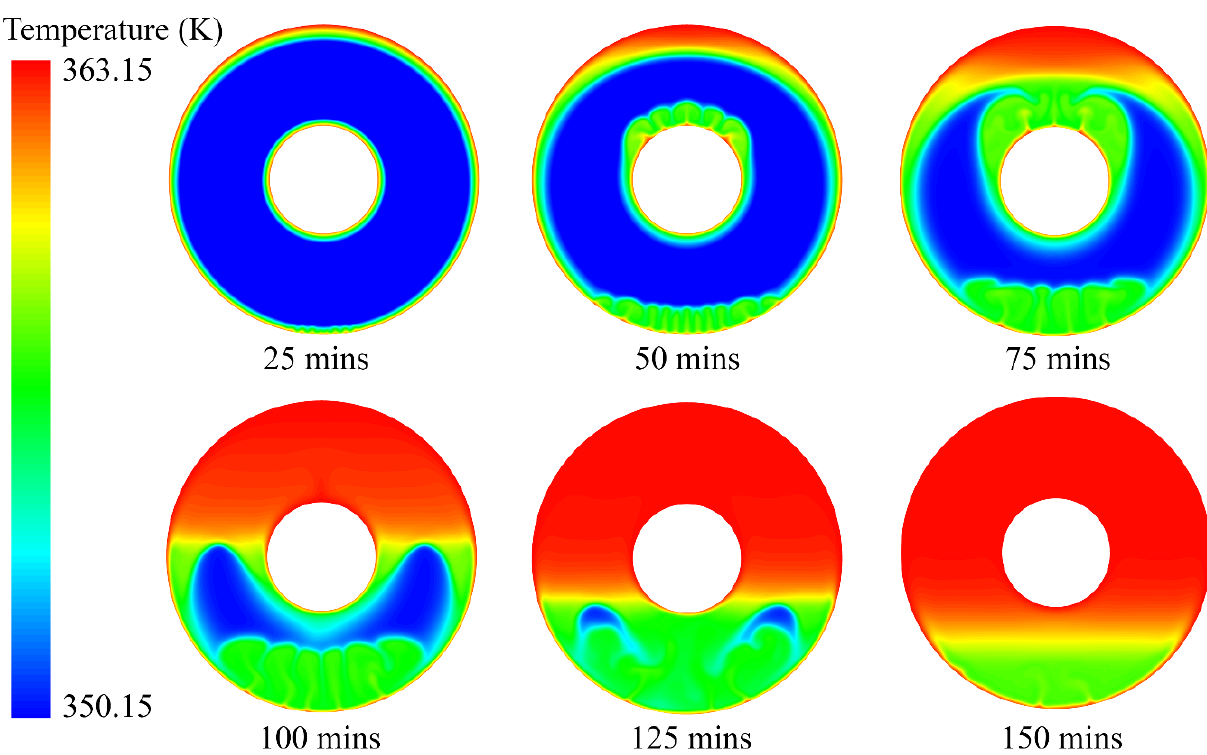
Figure 6. Temperature distribution of PCM during the melting process.